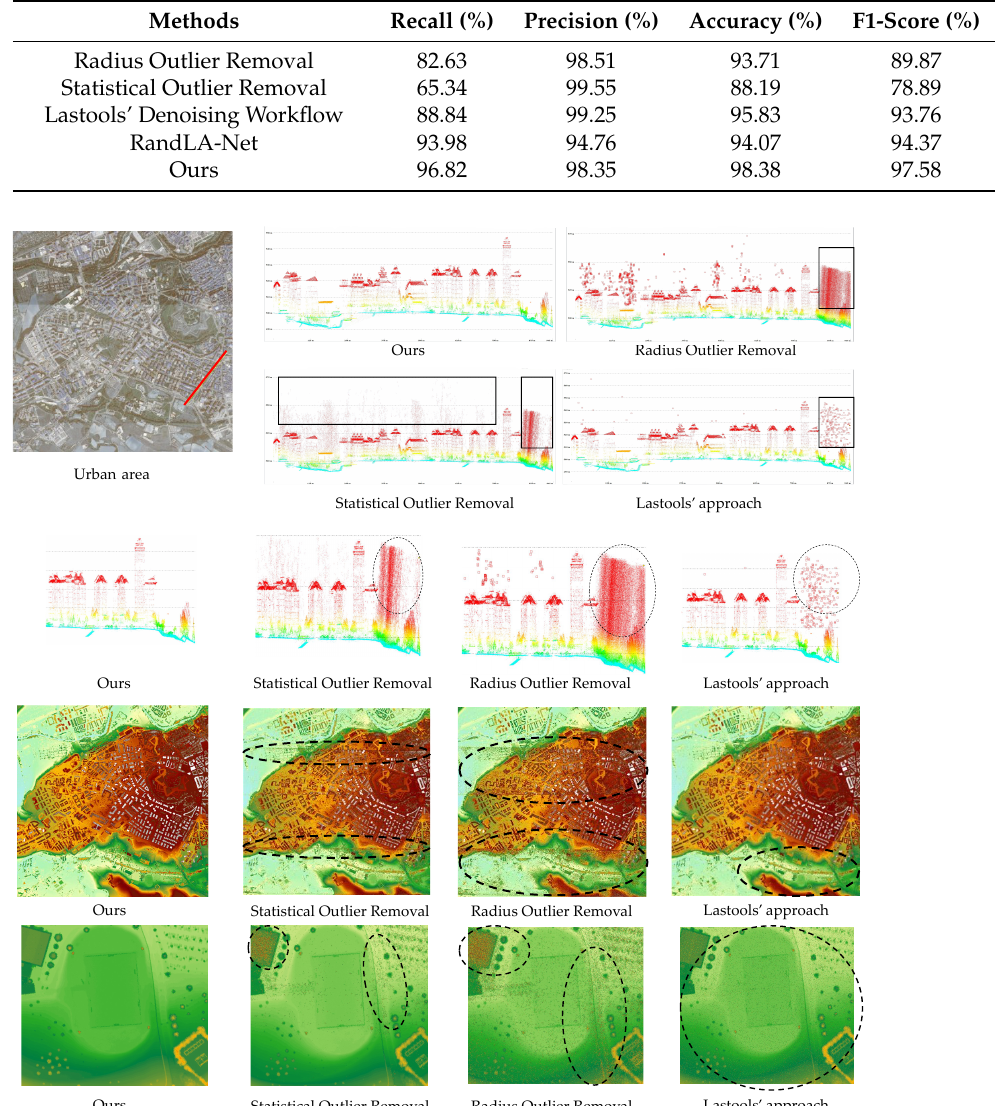
Figure 6. Examples of the denoising results in the urban area. The four images in the upper right- hand corner show the profile line in the area of the red line on the left. The third row represents the profile line partial details for convenient comparison. The fourth row indicates the DSM gen- erated by the different denoising methods. The bottom row indicates some details of the DSM to facilitate